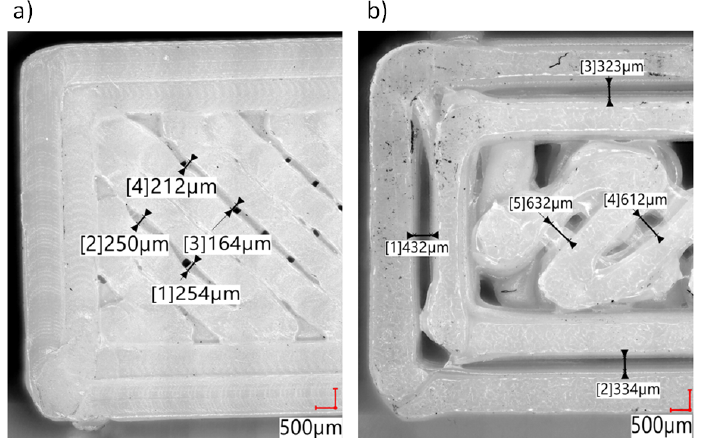
Figure 9. Microscope images of the outer layer of tested specimens with example path gap meas- ured: ( a ) 0.8 mm diameter nozzle, ( b ) 1.2 mm diameter nozzle. ( a ) 0.8 mm diameter nozzle, ( b ) 1.2 mm diameter